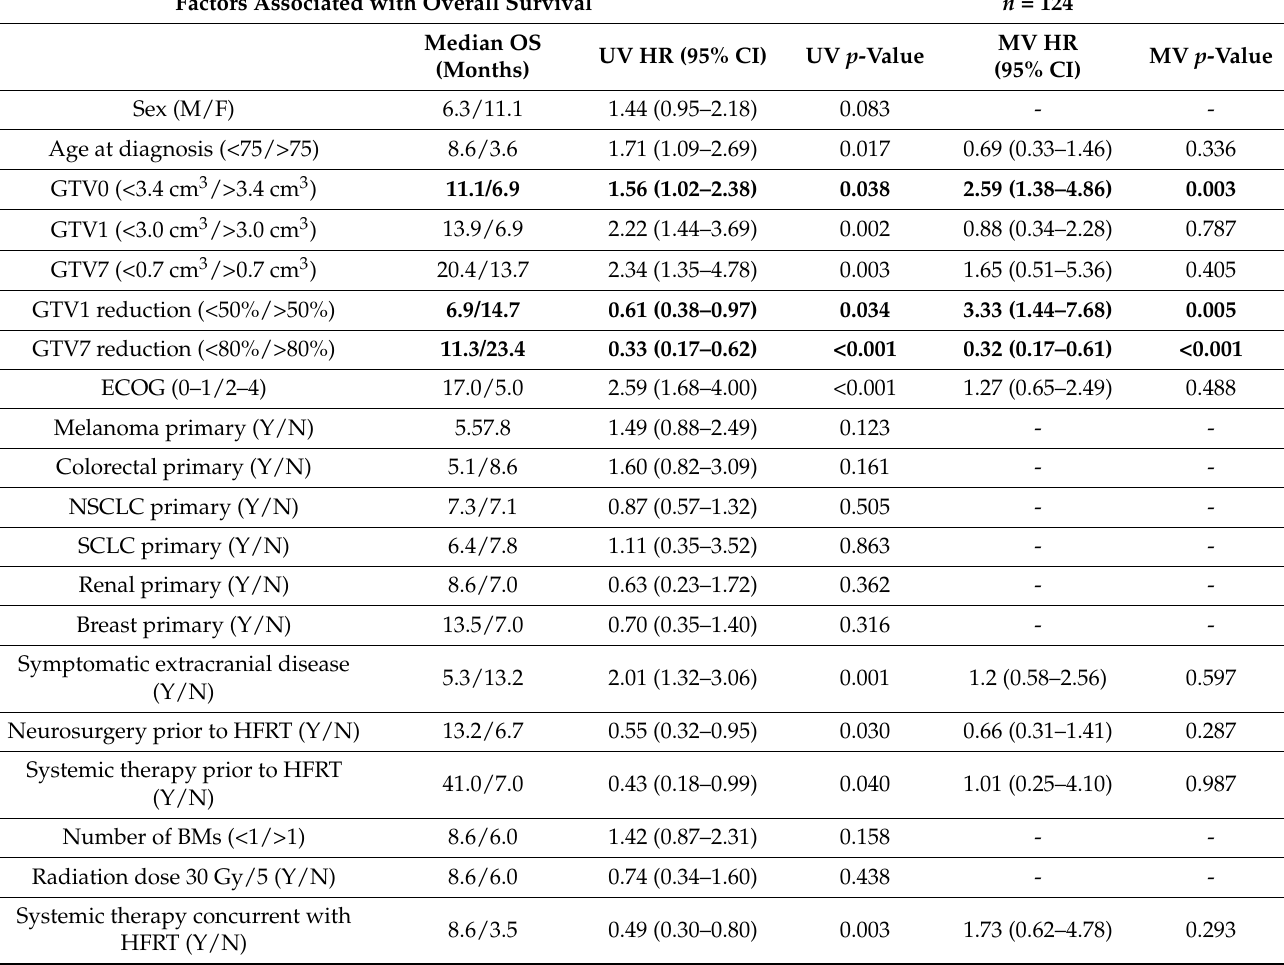
Table 4. Factors predictive of overall survival. BM = brain metastasis, GTV0 = volume pre-HFRT, GTV0 = volume at one month post-HFRT, GTV7 = volume at seven months post-HFRT, HFRT = hypofractionated radiotherapy, MV = multivariate analysis with Cox regression, NSCLC = non-small cell lung cancer, OS = overall survival, SCLC = small-cell lung cancer, UV = univariate analysis with Log-rank